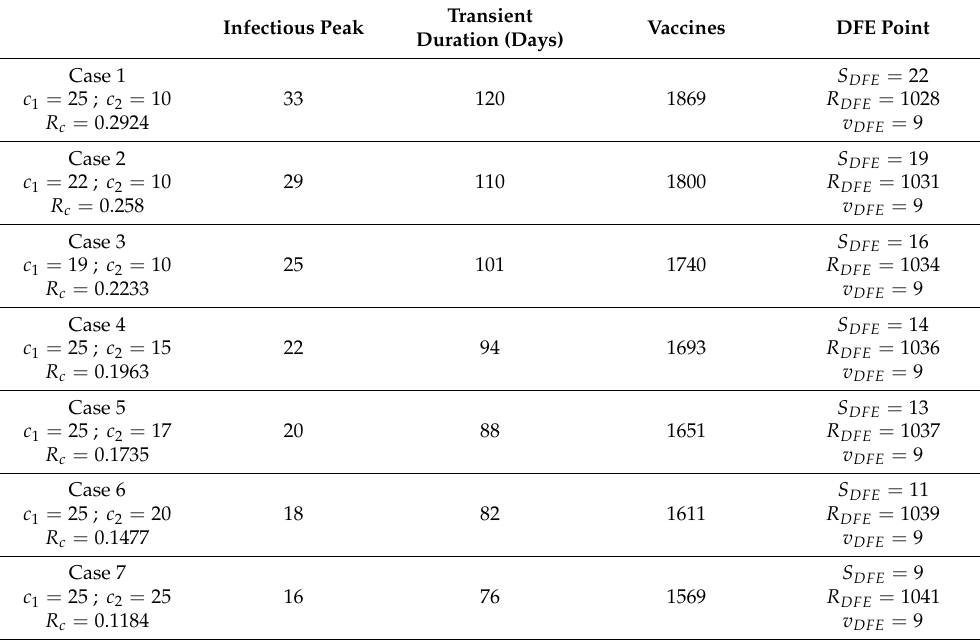
Table 3. Specifications of the model behaviour for seven considered pairs of values of the control parameters c 1 and c 2 when there is not treatment to control the disease